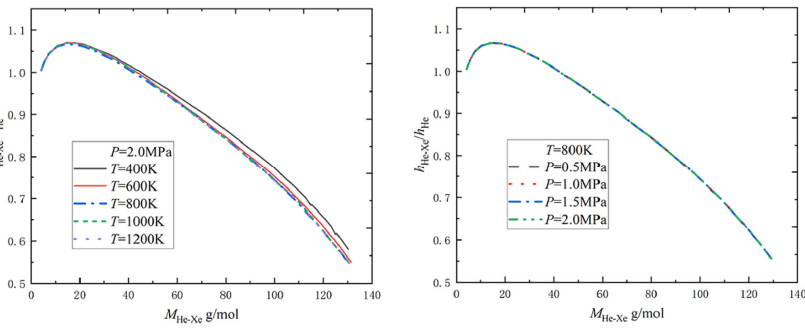
Figure 4. Relative heat transfer coefficient of the helium–xenon gas mixture [1,8].